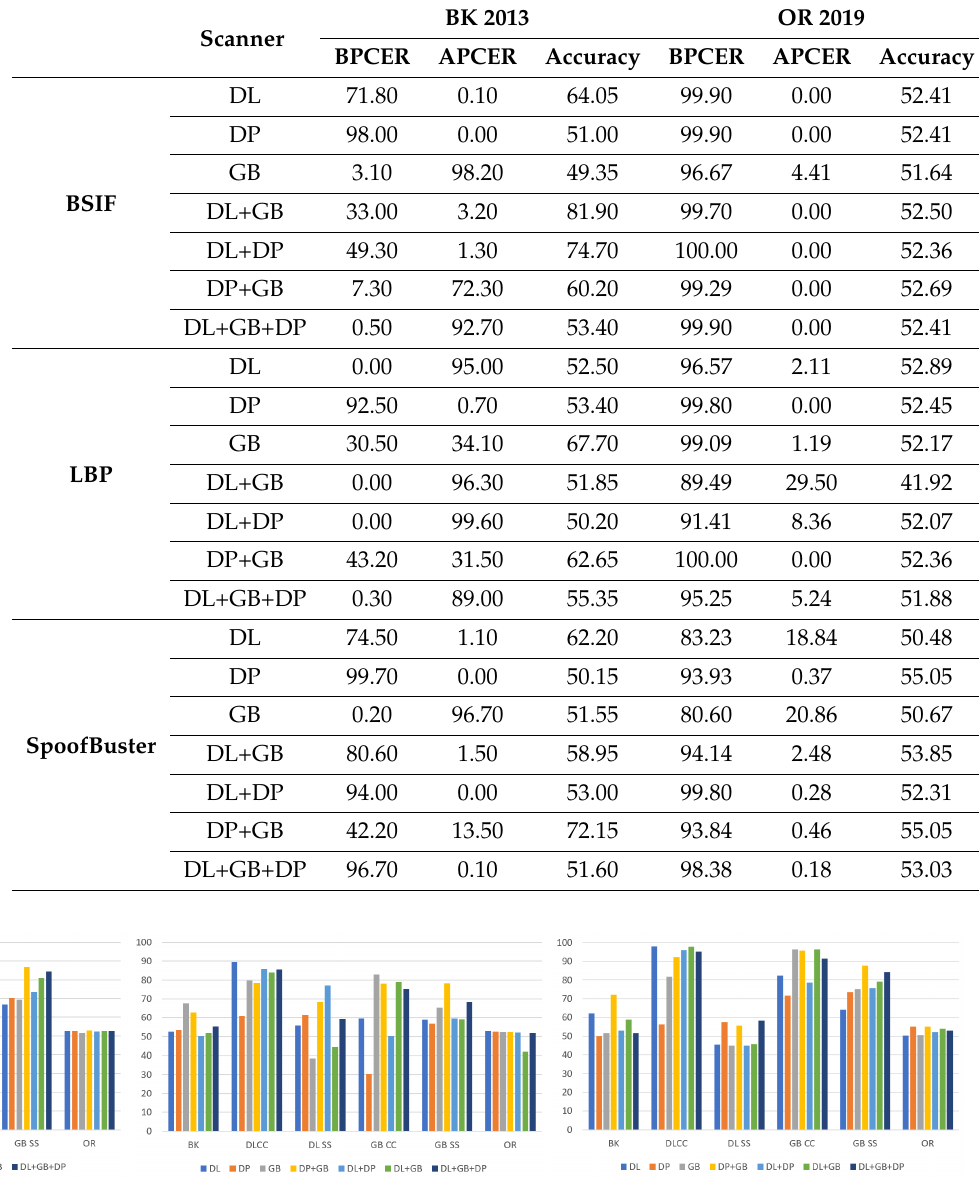
Table 9. Results in terms of accuracy, BPCER, and APCER with a threshold at 0.5 of BSIF, LBP, and SpoofBuster PADs with different single-sensor and multi-sensor training techniques for earlier LivDet editions datasets.